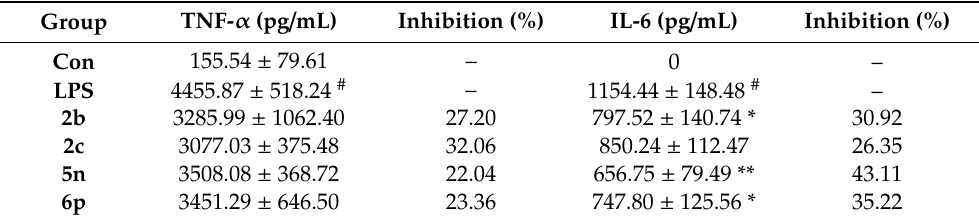
Table 3. The inhibition of compounds (1 µ M) on cytokines release (48 h) of the murine microglial cell